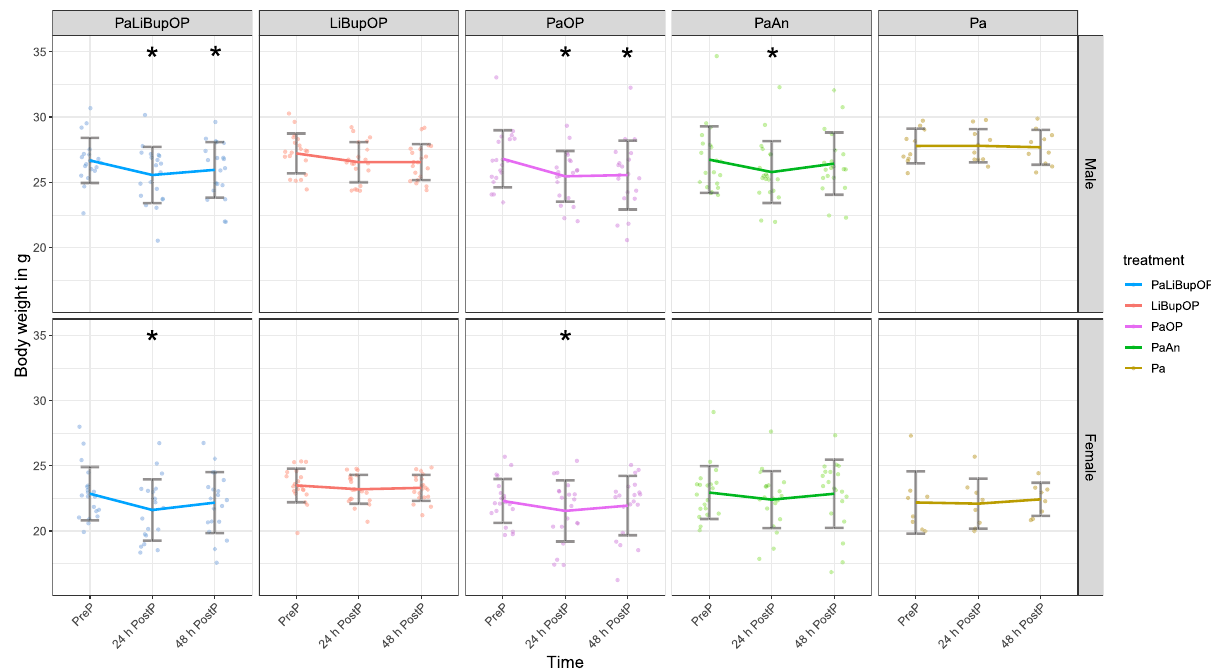
Figure 4. Absolute body weight in grams measured immediately before surgery/anesthesia (Pre-procedure) and 24 h and 48 h after. In both sexes, the Bonferroni post hoc test detected no differences between the treatment groups at Pre-procedure. In male mice, the Bonferroni post hoc test revealed significantly lower body weight in PaOP compared to Pa at 24 h post-procedure. Significant differences to the respective baseline measurements within one treatment group are indicated with *p ≤ 0.05, Dunnett’s post hoc. Data are shown as scatter dot plot with mean ± SD. Numbers per group: PaLiBupOP, LiBupOP, PaOP, and PaAn n = 20/each sex; Pa male n = 10, Pa female n =